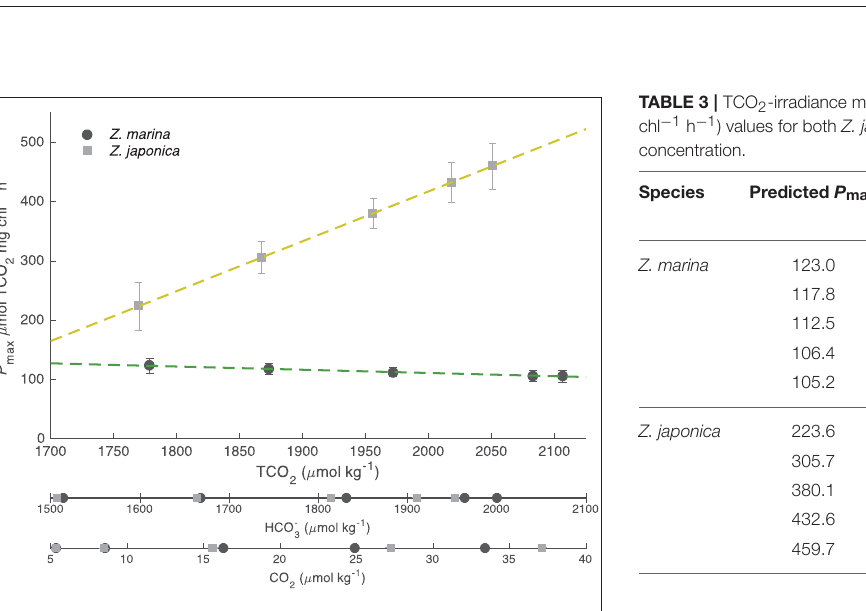
FIGURE 3 | Model predicted maximum photosynthetic rates ( P max ) for Z. japonica (closed squares) and Z. marina (closed circles) as a function of TCO 2 , HCO − 3 , and CO 2 with SE. Discrete HCO − 3 and CO 2 concentrations are the initial values for each treatment corresponding to p CO 2 - and TCO 2 -values ( Table 1 ). Dashed lines are the linear fits of the predicted P max for Z. marina (green) and Z. japonica (yellow), which is the β term from the TCO 2 -irradiance model ( Table 2